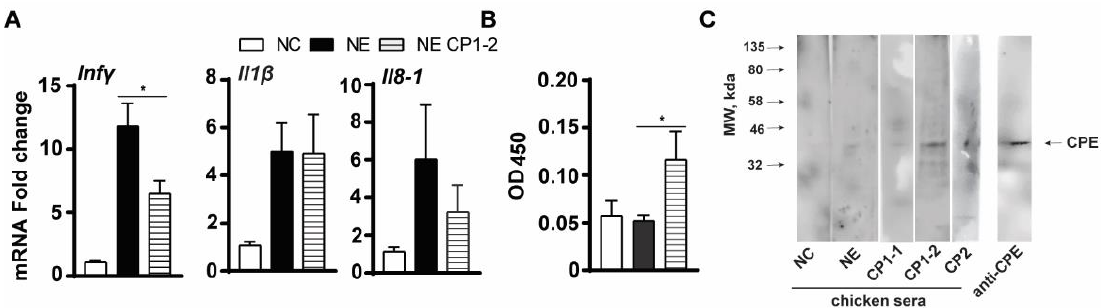
Figure 6. CP1-2 vaccine reduced NE-induced inflammatory response. Bird experiment was conducted as in Figure 4. ( A ) Proinflammatory gene expression in the small intestinal tissue. ( B ) ELISA result using antigen of CP-spor-super1 and primary antibody of individual serum from the birds. ( C ) WB result using antigen of CP-spor-super1 and primary antibody of group-pooled sera from the birds as well as anti-CPE primary antibody. All graphs depict mean ± SEM. *, p < 0.05.